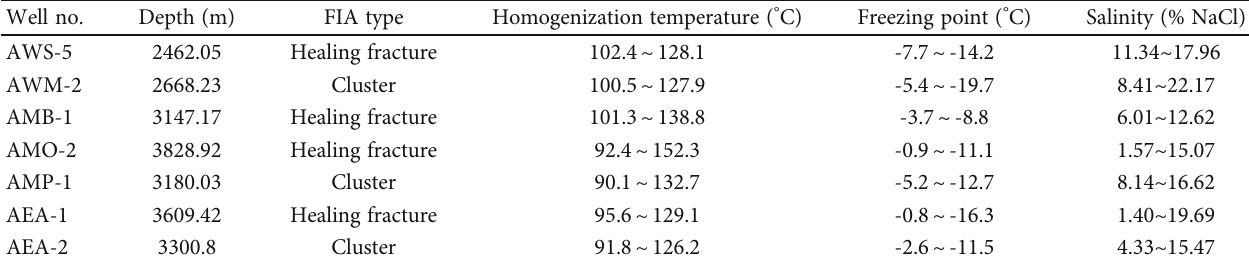
k-J o reservoirs in the ADRRB. 2 3